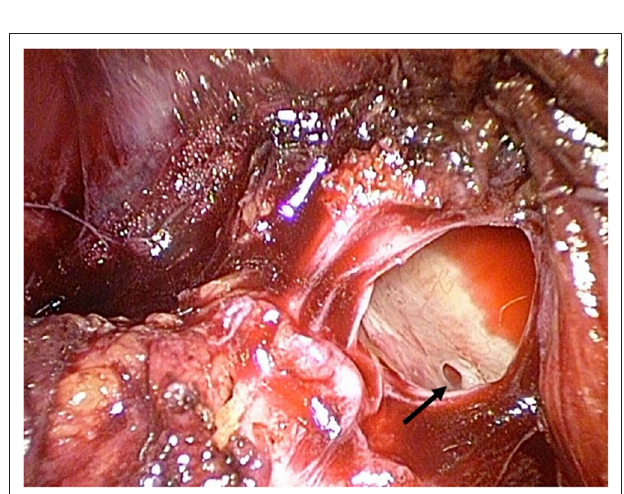
FIGURE 2 | The preperitoneal pressure is increased to 14 mmHg; the intraluminal blood volume is now more compressed and a venous branch is visible through the injured lumen (black